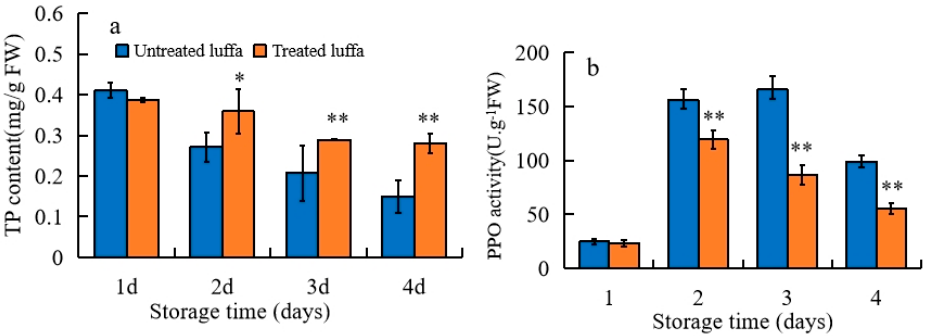
Figure 4. Effect of CaCl 2 treatment on ( a ) TP and ( b ) PPO activity in fresh-cut luffa. Each value is presented as mean ± SE ( n = 3). ** and * represent extremely significant differences and significant differences, respectively ( p < 0.05 and p < 0.01, respectively). TP, total phenol; PPO, polyphenol oxidase.